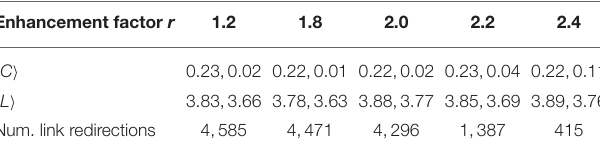
TABLE 1 | Evolution of network statistics during a run of 40 rounds as a function of the enhancement factor r . Enhancement factor r